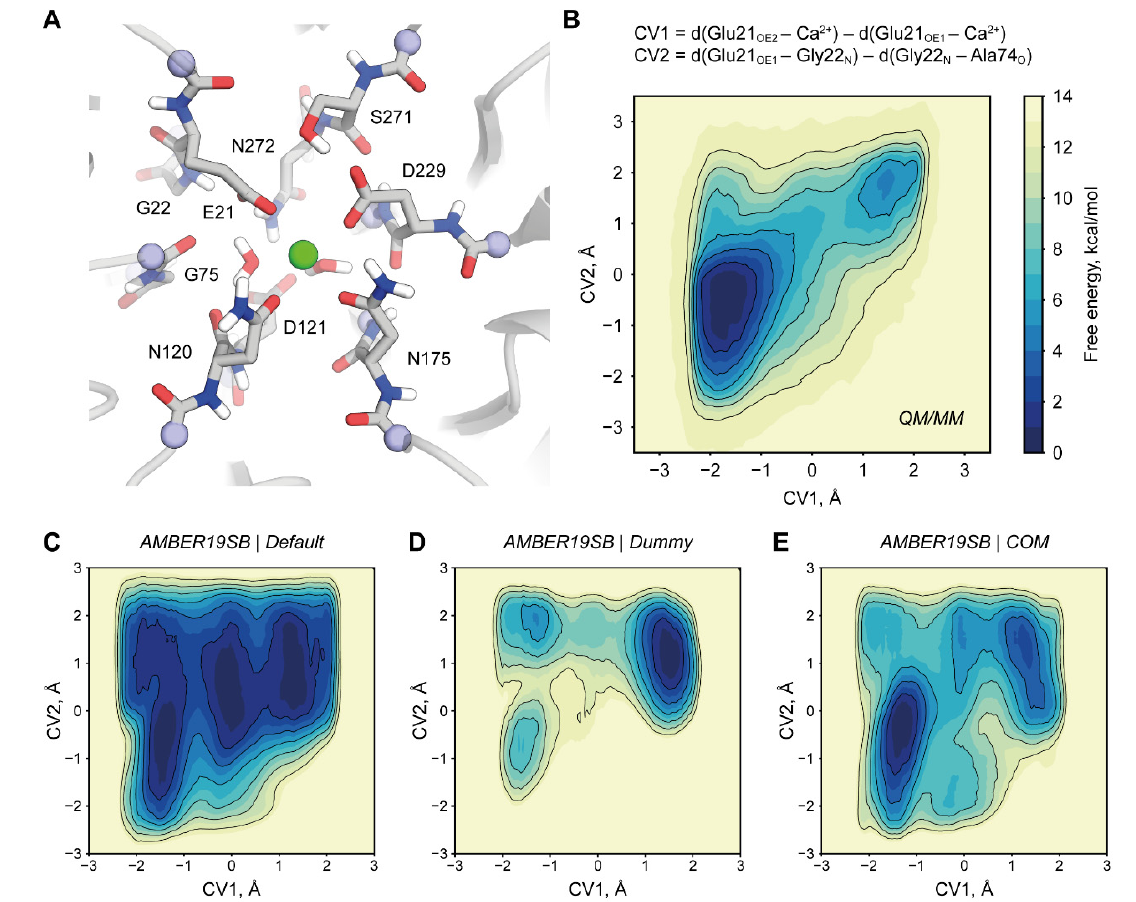
Figure 3. Competition for a hydrogen bond with G22 and its influence on the E21 conformation studied with QM/MM and MM treatment. ( A ) Composition of QM subsystem. Linking atoms are shown in blue. ( B ) QM/MM free energy profile of E21 conformation switch. ( C – E ) Free energy profiles of Amber19sb systems showing the benefit of using the COM metal model to approach QM/MM reference. Similar data for other force fields are shown in Figure S4. Non-polar hydrogen atoms are omitted for clarity.